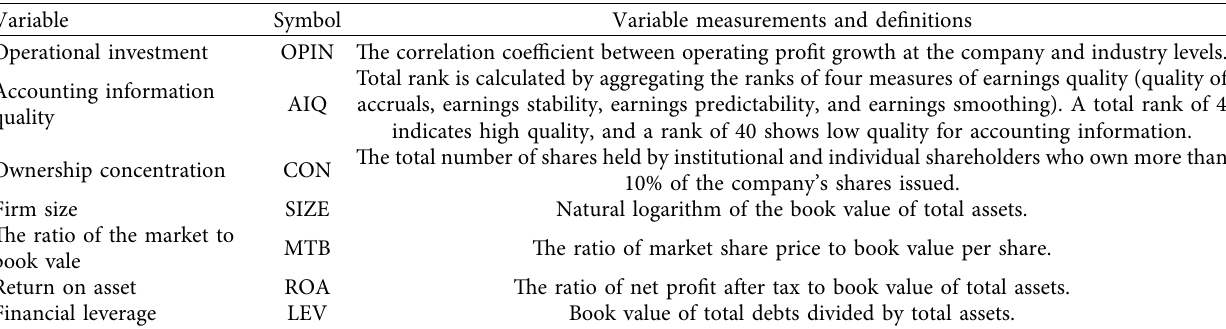
Table 1: Variable definitions.